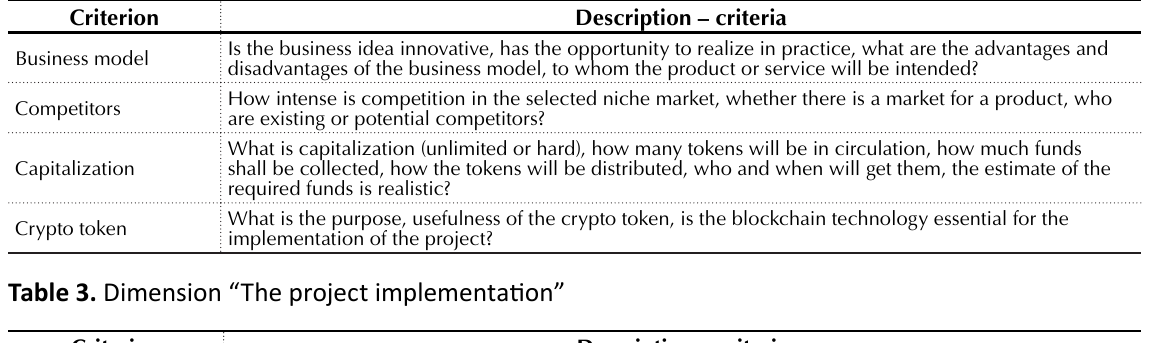
Table 2. Dimension “The project strategy”